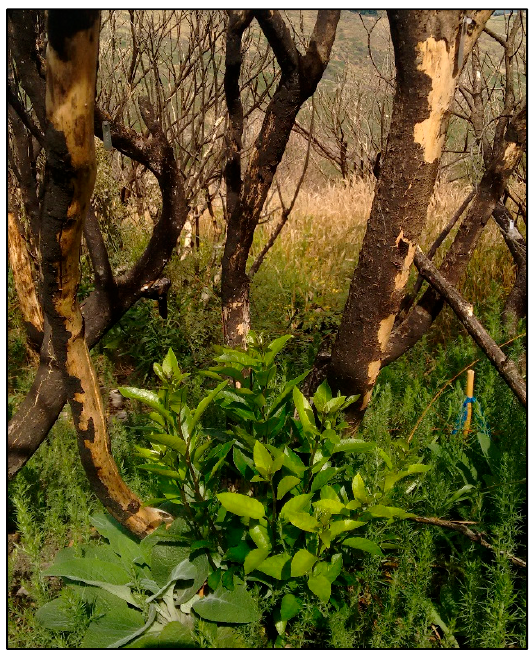
and Ulex europaeus seedlings .